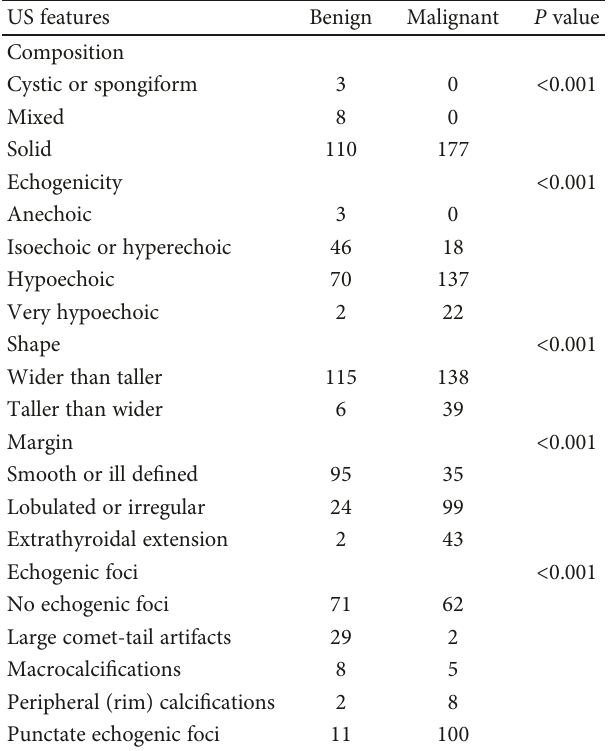
Table 2: Conventional US features for di ff erentiating thyroid lesions.